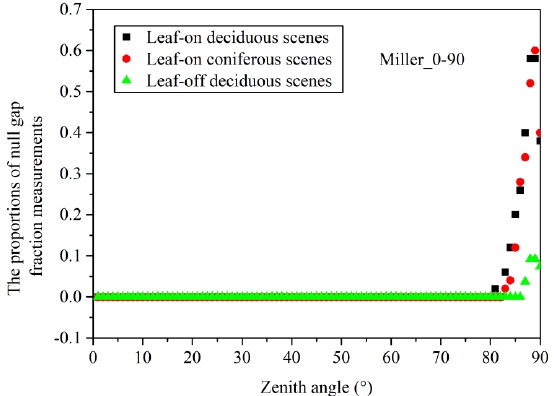
Figure 4. Proportions of number of scenes with null gap measurement at each zenith angle to the total number of leaf-on and leaf-off scenes for Miller_0-90.